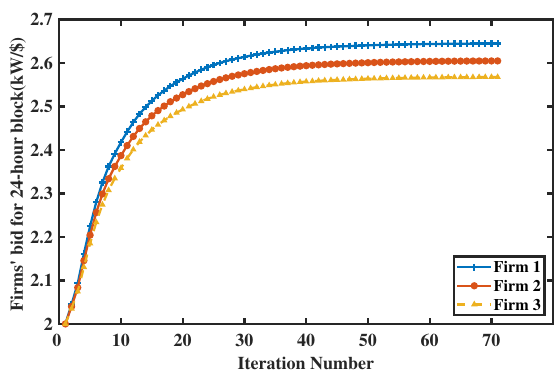
Figure 11. Convergence process of firms’ strategic bids for the 24-h load block.